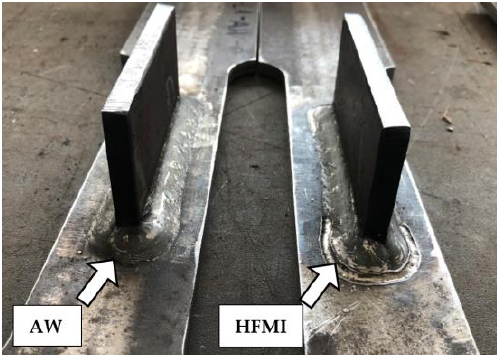
Figure 1. Untreated weld toe — AW ( left ) and treated weld toe — HFMI ( right ) on the specimen with longitudinal attachment.